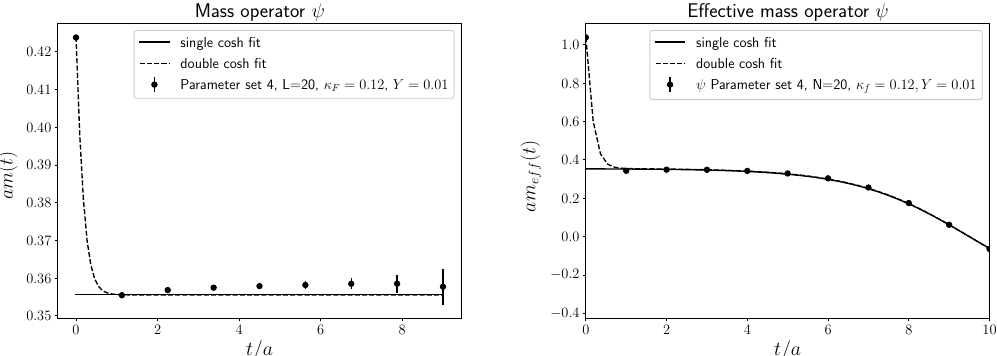
Figure 2: Example of the effective mass from the gauge-fixed propagator (21) for = 0.12 and Y = 0.01. The fit stems from a two-cosh system 4 on a 20 4 lattice at κ F fit, of which the lower mass is also shown alone, to emphasis the non-monotonous behavior at short times. Errors are smaller than the symbol size. The top-panel shows the effective mass as defined in (24), while the lower panel shows the effective mass as defined in (27). Note the different scale in both